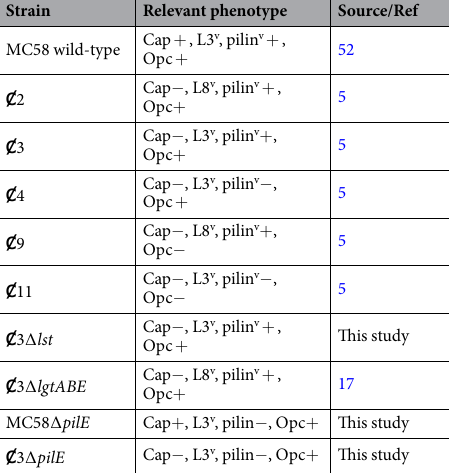
To fully characterise the glycan interactions revealed above, we used purified meningococcal surface components to investigate their direct bind- ing to host glycans, and to quantitate binding affinities. Here we describe detailed analysis of two meningococcal surface components; Opc and LOS. Affinity determination of Opc-mediated glycan binding. Opc-mediated glycan binding was further investigated using outer membrane preparations from the Opc expressing strain ( Ȼ 4) and the isogenic Opc mutant strain ( Ȼ 11). Isothermal titration calorimetry (ITC) was used to confirm interactions and quantify binding affinities of five glycans, chosen from the 43 glycan interactions putatively ascribed to Opc based on the glycan array analysis of the wild-type and Opc mutant strains (above). Five of the interactions tested were high affinity, with a dissociation constant (K D ) below 5 µ M (Table 2, Supplementary data S1). Consistent with previous reports 16 , Opc bound 2,6 sialylactose with a K